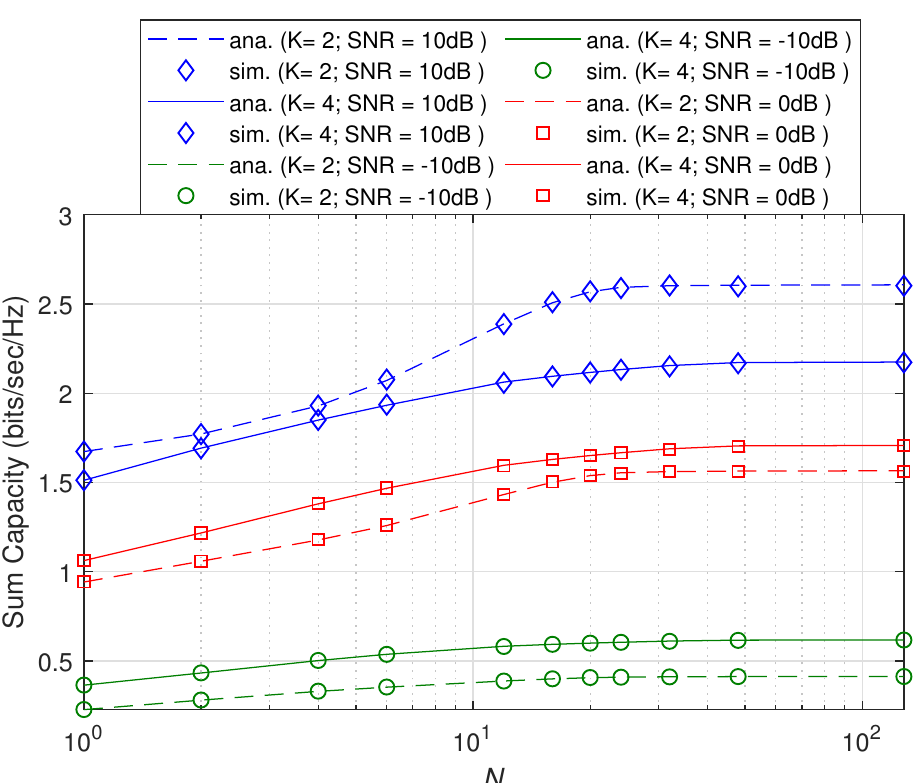
Figure 3. Comparison of analytical and simulation results of the sum capacity rate versus the transmit antenna order N in log scale.